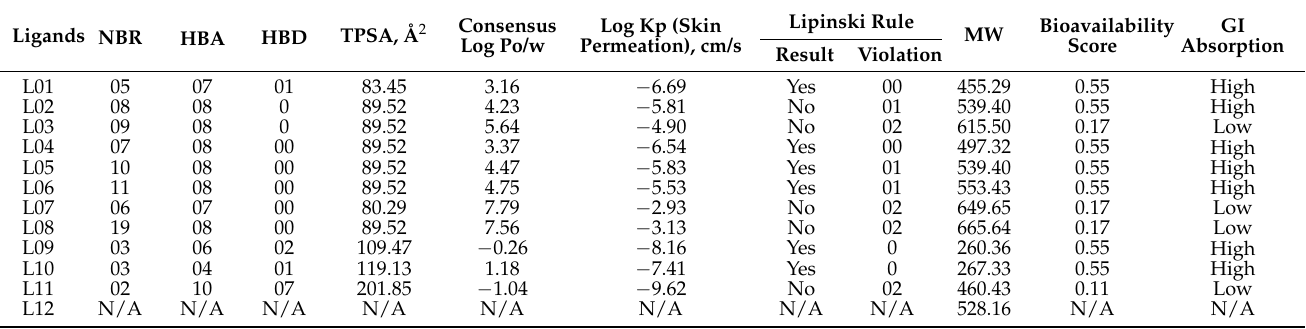
Table 6. Data of Lipinski rule, pharmacokinetics, and drug